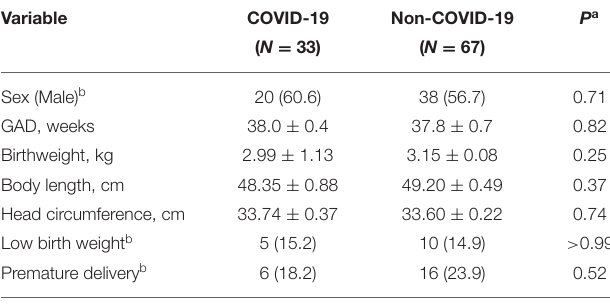
TABLE 2 | Baseline characteristics and clinical characteristics of the follow-up infants.